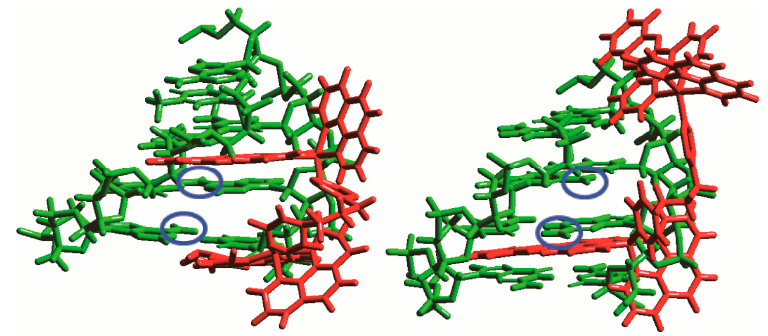
Figure 6. Schematic diagrams of the bis ‐ Ru ‐ bpp ‐ complex ‐ DNA. Both the dppz ligands intercalate between the DNA base ‐ pairs (left diagram) in case of poly[d(A ‐ T) 2 ] and one dppz is intercalated and the other exposed to solvent (right diagram) in case of poly[d(G ‐ C) 2 ]. The blue circle indicates position of amine group in minor groove direction.